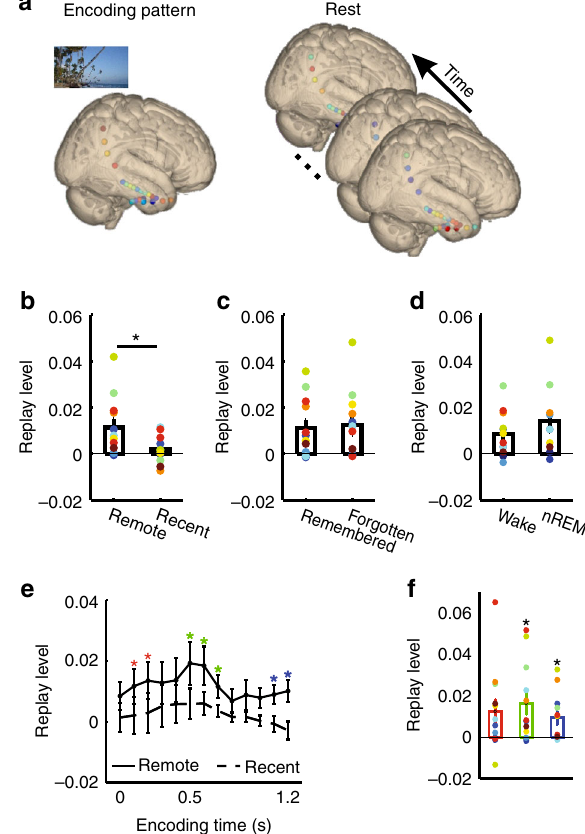
Fig. 3 Spontaneous replay during rest. a Schematic illustration of analysis procedure. Reactivation is quanti fi ed by correlating activity during each encoding event and each time period during the resting state. Each circle in the brain indicates one channel. The hotter the color of the circle, the higher the EEG power. b Higher replay of stimulus-speci fi c activity from late encoding cluster (500 – 1200 ms) of remote vs. recent items. * indicates p < 0.05 (paired t test). Reactivation does not differ between remembered and forgotten remote items c or between waking state and nREM sleep d . e Encoding-time resolved replay during rest. Reactivation differs between remote and recent items in three time periods marked with *s in different colors after cluster-based correction for multiple comparisons (surrogate data was generated by switching remote and recent labels). f Averaged replay levels of all clusters depicted in e as compared to zero. Each colorful dot indicates one participant. Same colors indicate data from the same participant. Error bars, standard error of the mean; * indicates signi fi cant difference from zero (one sample t -test, p <